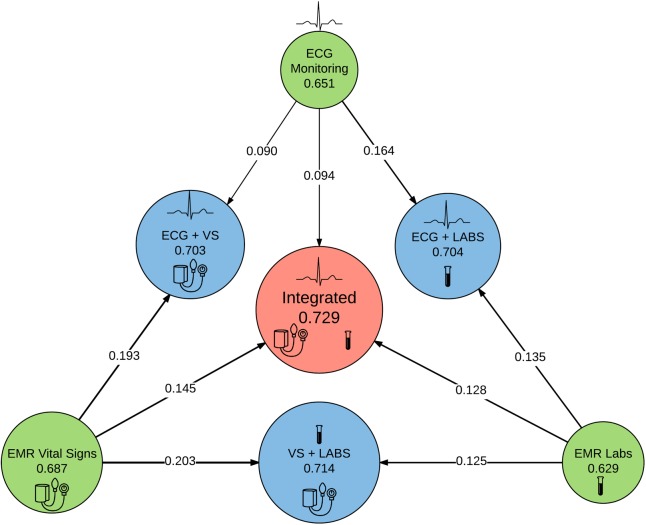
Schematic of sequential integration of additional data sources.Each circle represents an individual model with the C-statistic reported below each model abbreviation. Area of each circle is proportionate to the total likelihood ratio test χ2 minus two times the degrees of freedom (df) of all non-intercept terms.